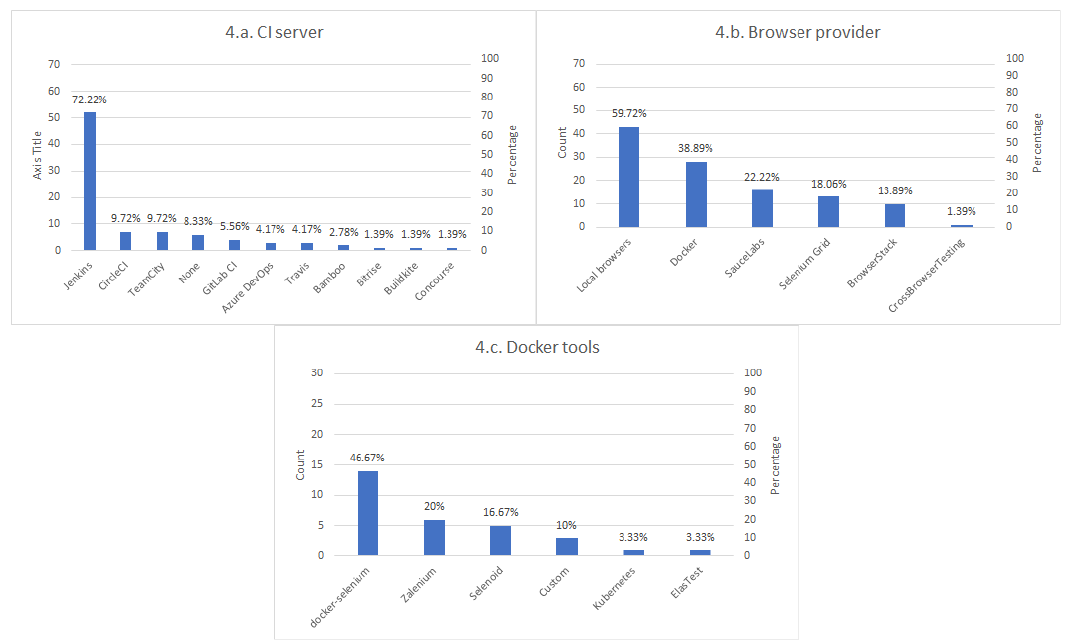
Figure 10. Infraestrucutre for Selenium